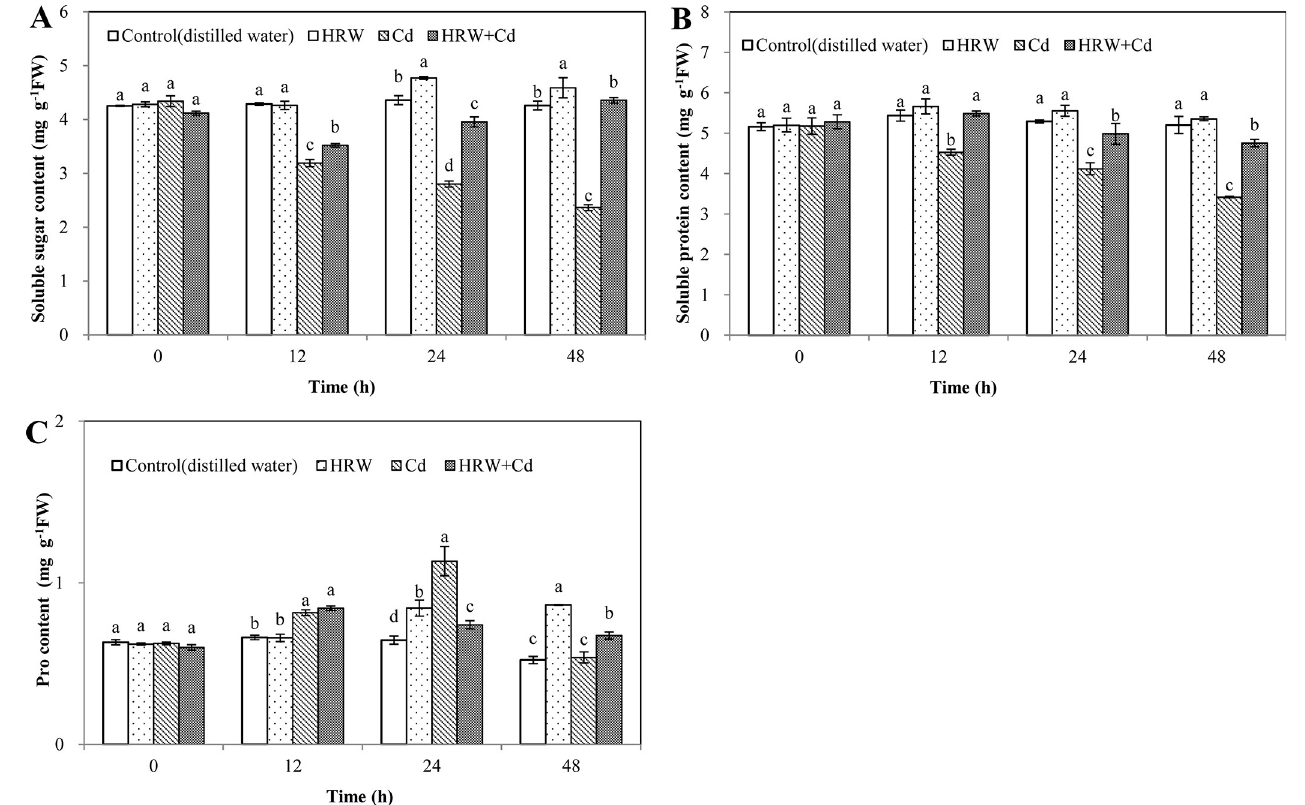
Fig 7. Effects of HRW on the content of soluble sugar, soluble protein and Pro during adventitious root development in cucumber under Cd stress. The primary roots were removed from hypocotyls of 5-day-old cucumber seedlings. Explants were incubated for 2 d with distilled water (control), 50%HRW, 1 μ M Cd(NO 3 ) 2 , 50%HRW+1 μ M Cd(NO 3 ) 2 . The content of soluble sugar ( A ), soluble protein ( B )and pro ( C ) were measured at 0, 12, 24 and 48h and expressed as mean ± SE, respectively. Bars not sharing the same letters were significantly different ( P <